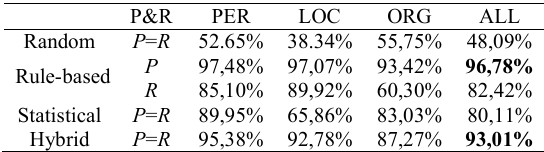
Table 4. Precision and Recall after running Algorithm 2 in the three modes on the dataset D